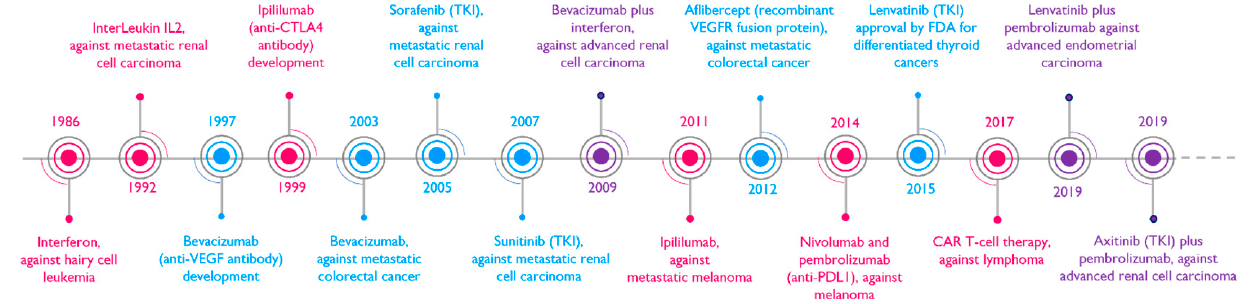
Figure 2. Some milestones in clinical trials against cancers based on anti-angiogenic and/or immunomodulatory strategies. This timeline integrates information about the development of anti-angiogenic (in blue) and immunotherapy (in pink) anti-cancer strategies, or the combination of both approaches (in purple), with the dates of their approval by the FDA for the treatment of specific cancers.